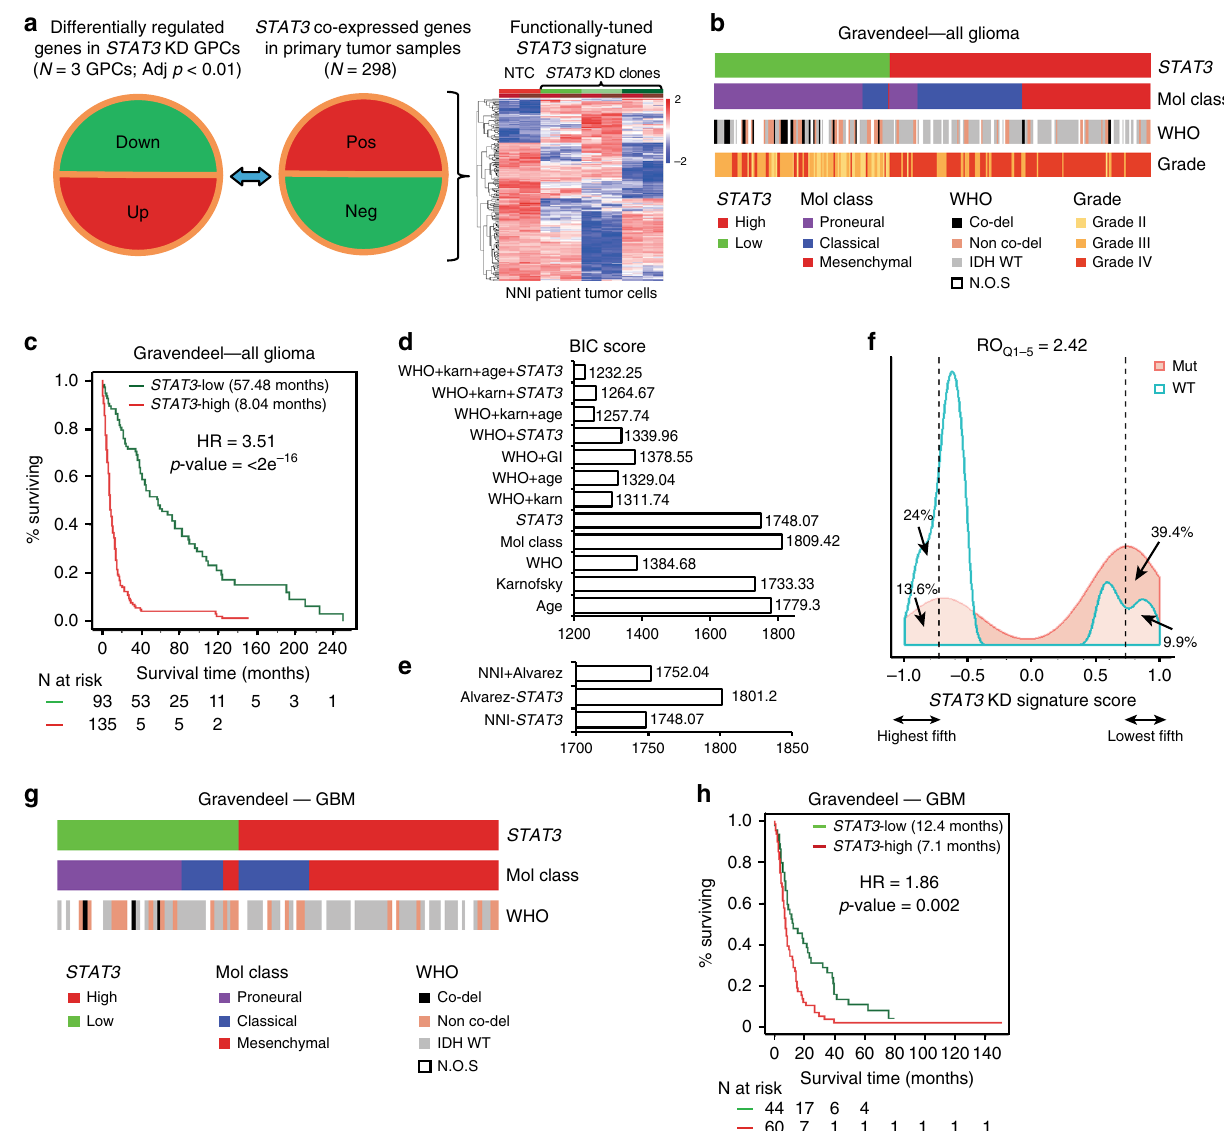
Fig. 1 NNI- STAT 3 functionally tuned gene signature strati fi es patient survival independent of current clinical indicators. a STAT3 co-expressed genes from Rembrandt patient database (middle panel) that displayed inverse expression upon STAT3 knockdown (KD) (left panel) were identi fi ed to form the NNI- STAT3 functionally tuned gene signature (right panel). b In Gravendeel clinical database, STAT3 -high patient all glioma cohort was enriched in mesenchymal and classical molecular subtypes, with predominantly isocitrate dehydrogenase 1 (IDH)-wild-type status. STAT3 -low tumors, in contrast, comprised mostly low-grade gliomas (LGGs), IDH-mutant (1p/19q co-deleted and non-co-deleted), and proneural molecular subtypes. c NNI-